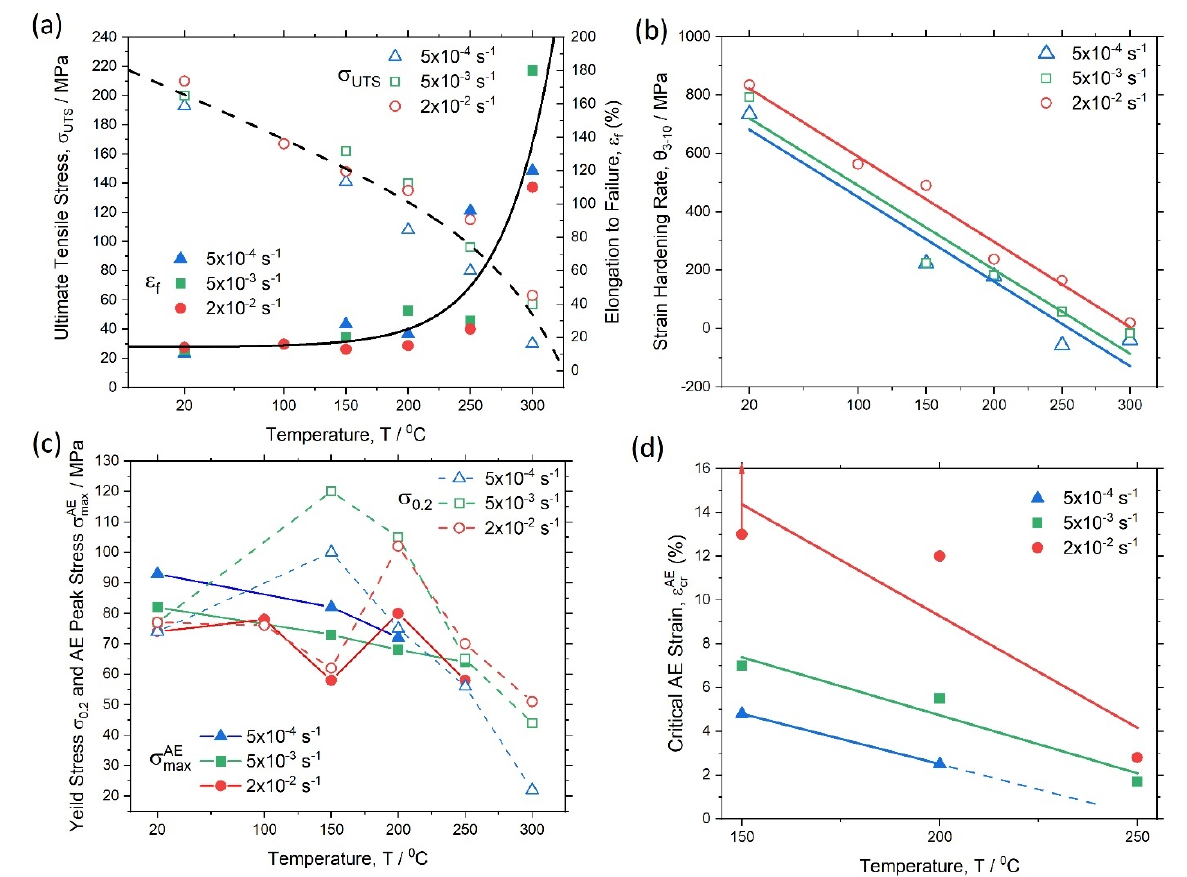
Figure 9. Dependence of mechanical properties and AE features on the test temperature: ( a ) ultimate tensile strength σ UTS and elongation at break ε f , ( b ) average strain hardening rate θ 3–10 , ( c ) conventional yield stress σ and AE (or physical) yield stress σ AE max , and ( d ) critical strain ε AE cr